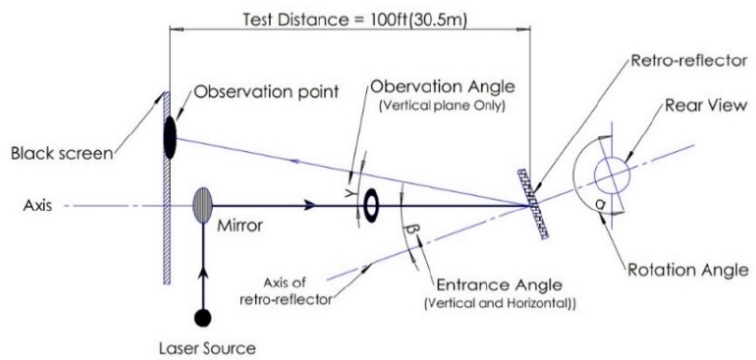
Figure 7. Experimental setup for testing samples (flat and curve).